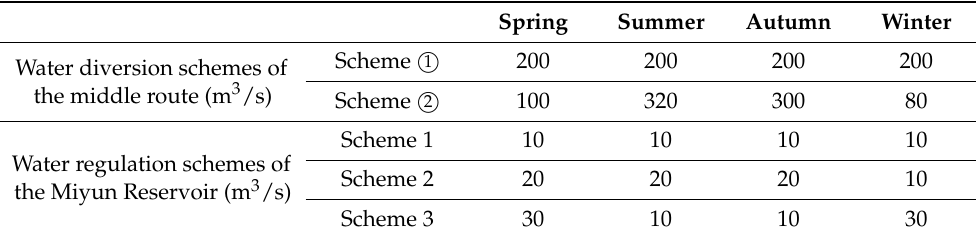
Table 2. Scenarios of water diversion schemes.